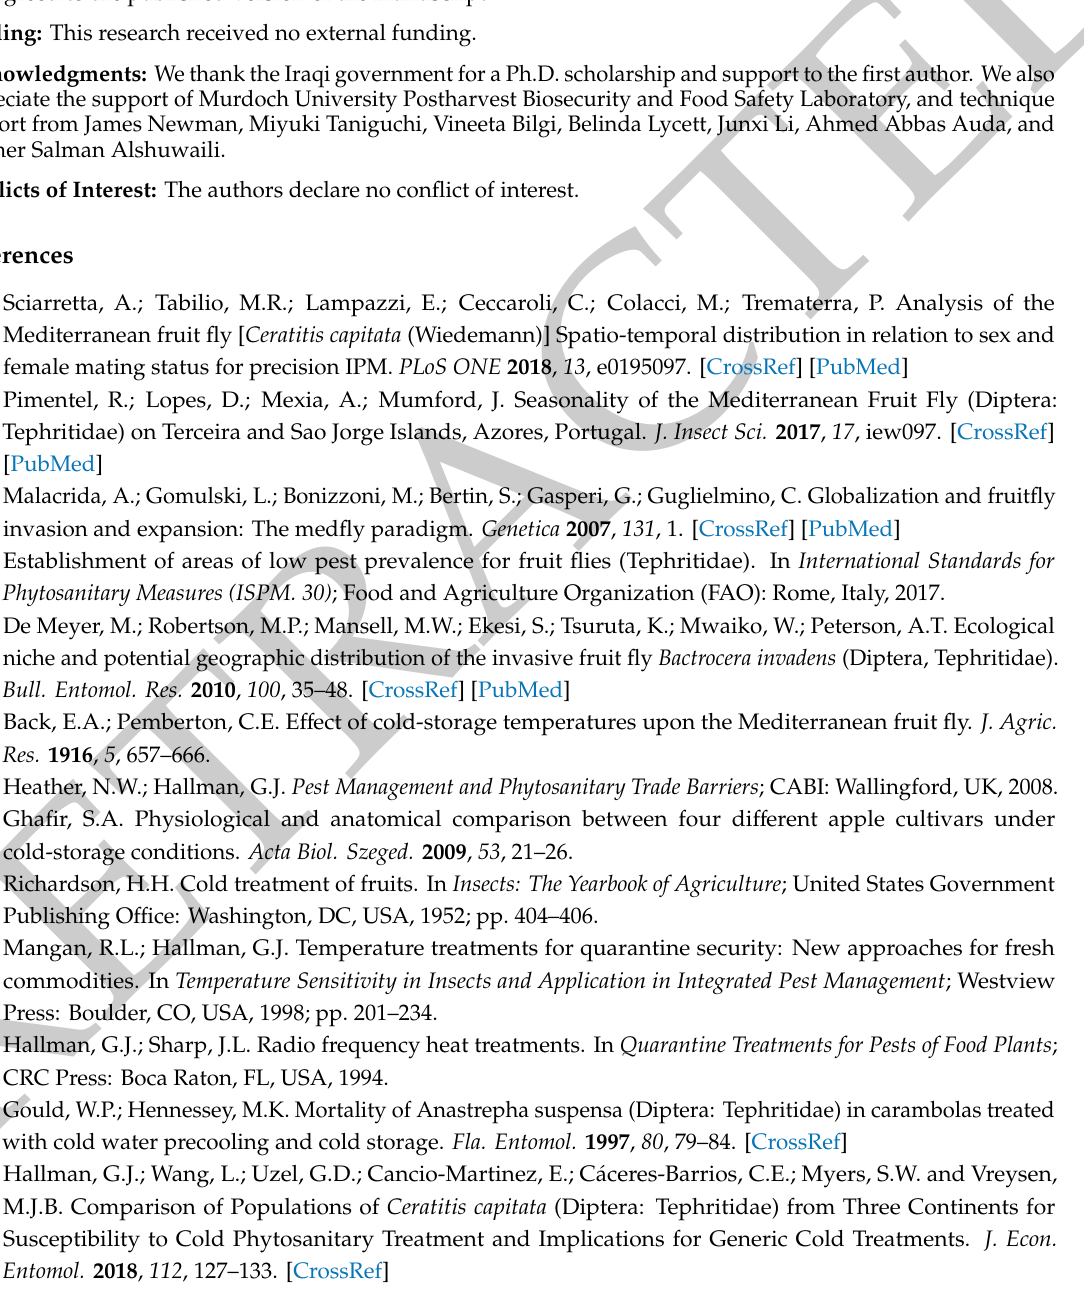
Table S1: Life history of immature stages of C. capitata in blueberry cultivar C99-42 and cultivar C00-09. Table S2: Test of normality according to Kolmogorov–Smirnov value and Shapiro–Wilk, the significant was < 0.05 in all C. capitata tests which mean all data follow the normal distribution. Figure S1: The average female adult ratios of survived adults on each day treatment of immature stages in blueberry cultivar C00-09 and C99-42. Error bar means standard error. An ANOVA single factor test was used to compare sex ratios, p > 0.05. Table S3: ANOVA table of natural infestation of Ceratitis capitata to blueberry cultivar C99-42 and cultivar C00-09 with four exposure